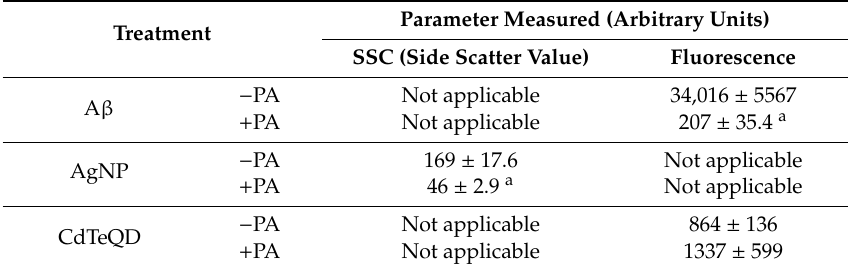
Table 2. Mean signal intensity of A β , AgNP and CdTeQD uptake by BV-2 cells pretreated (or not) with polyinosinic acid (PA).